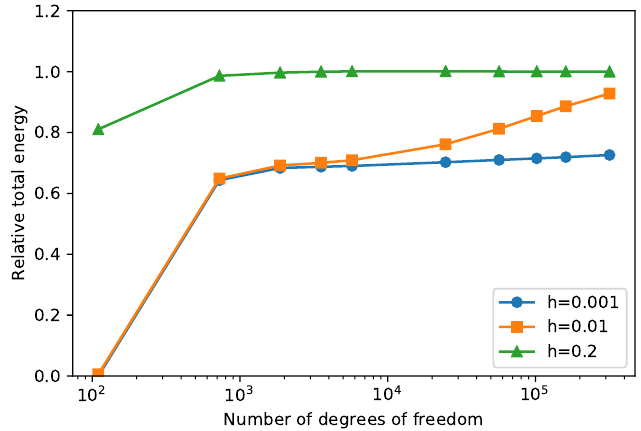
Figure 5. Total energy convergence for the linear mixed approach ( p = 1) for different